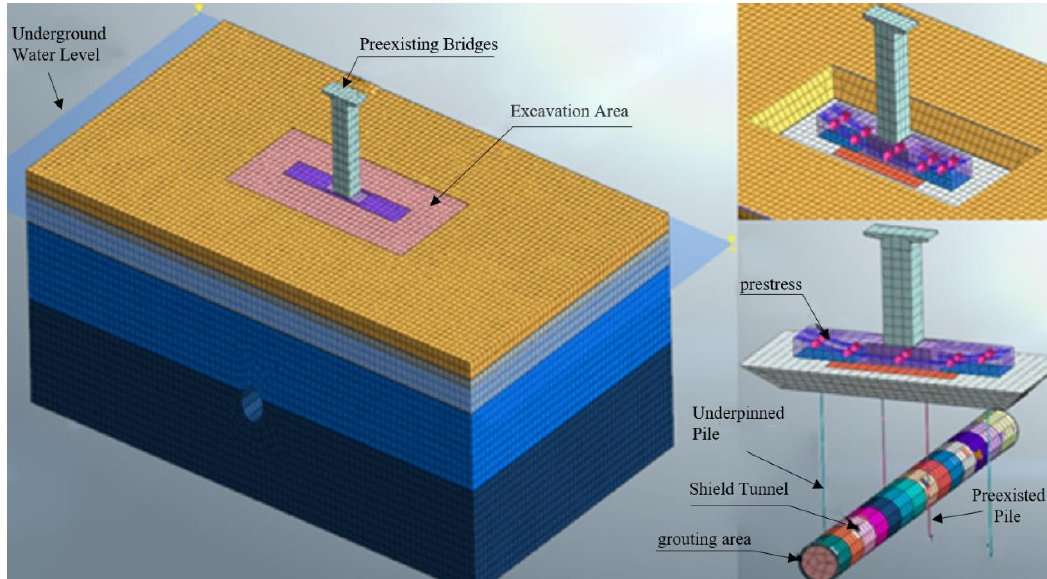
Figure 5. Numerical simulation model of pile foundation underpinning.